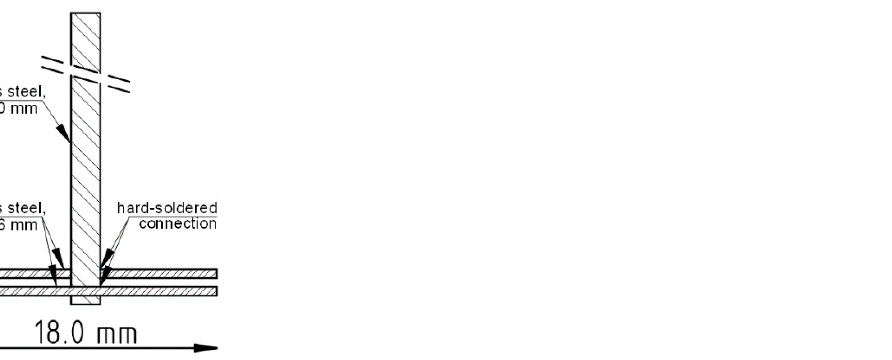
Figure 1. Technical sketch of the stirrer used in low-volume homogenisation of emulgels.